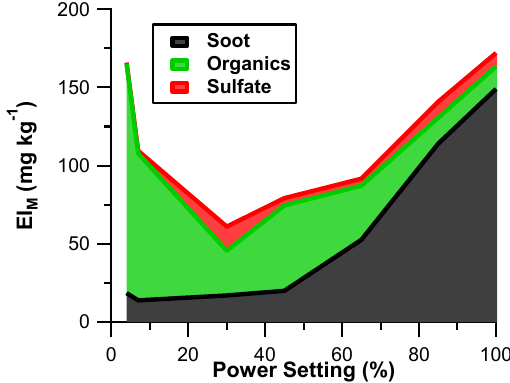
Fig. 11. Chemically resolved total aerosol mass emission index as a function of engine power. The total EI M was determined from the EI V assuming a density of 1.2gcm − 3 and the EI BC assuming a density of 1.1gcm − 3 . EI volatile is defined as the difference be- tween EI M and EI BC . EI Org and EI SO were then calculated from 4 the AMS organic and sulfate fractions of EI volatile . Data are solely from the #3 engine.